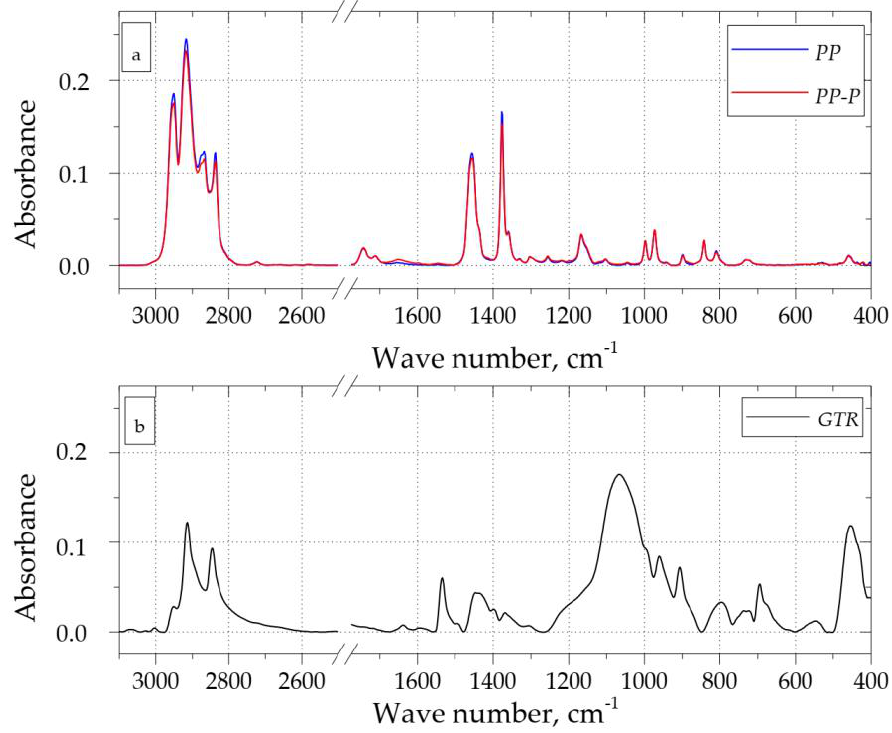
Figure 9. FT-IR spectra of PP, PP-P ( a ) and GTR samples ( b ).